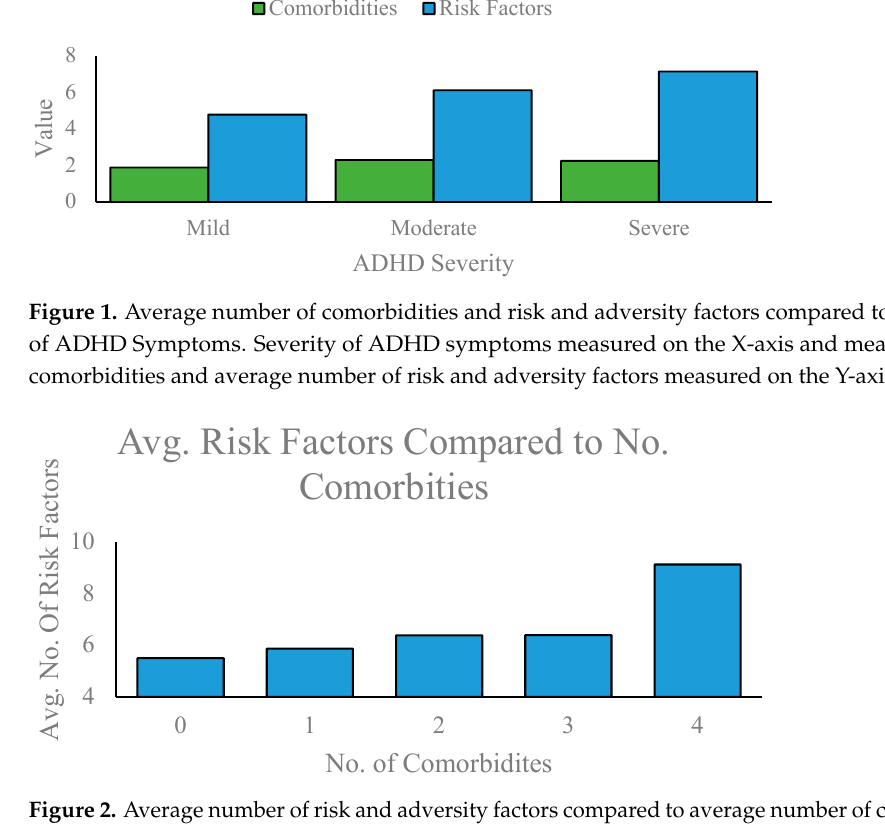
Figure 2. Average number of risk and adversity factors compared to average number of comorbidities. Number of comorbidities measured on the X-axis and mean number of risk and adversity factors measured on the Y-axis. The number of participant comorbidities ranged from 0 to 4, whereas possible risk and adversity factors ranged from 4 to 19.